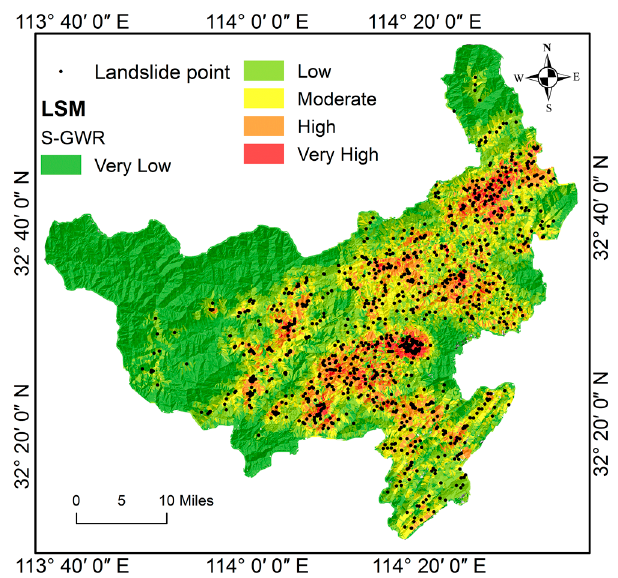
Figure 4. Landslide susceptibility mapping (LSM) by the proposed S-GWR model.